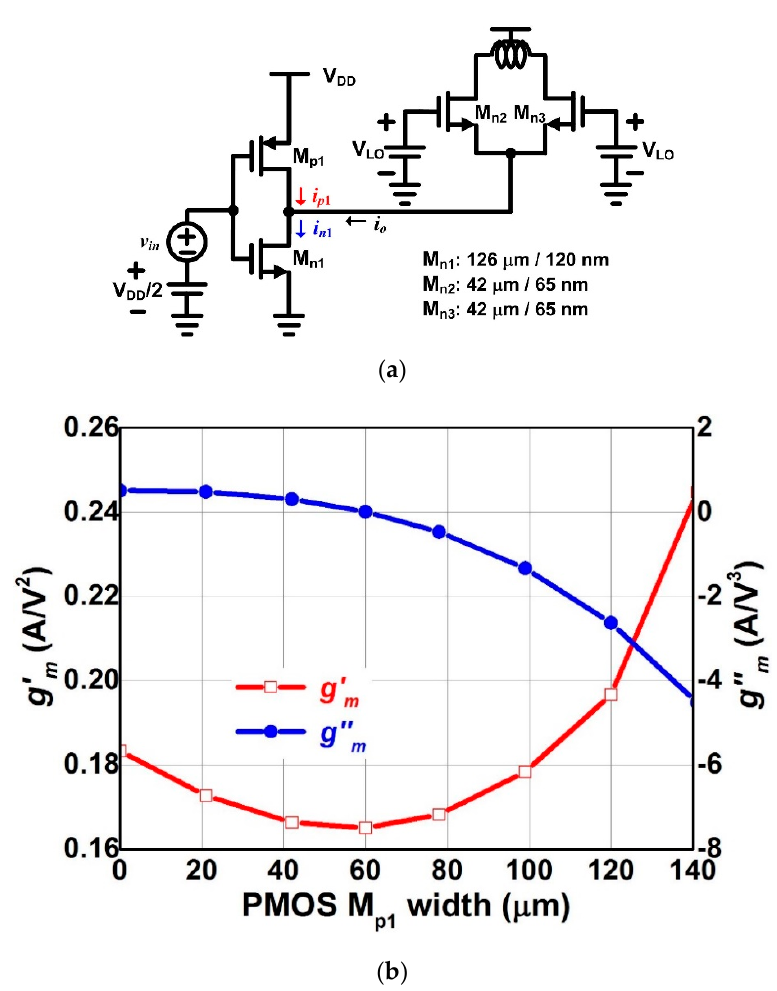
Figure 3. ( a ) Inverter-type transconductor (NMOS M n1 and PMOS M p1 ) and switching transistors M n2 and M n3 from up-conversion mixer, ( b ) g (cid:48) m and g (cid:48)(cid:48) m of small signal output current i o of inverter-type transconductor over the width of PMOS M p1 with a channel length of 65 nm.